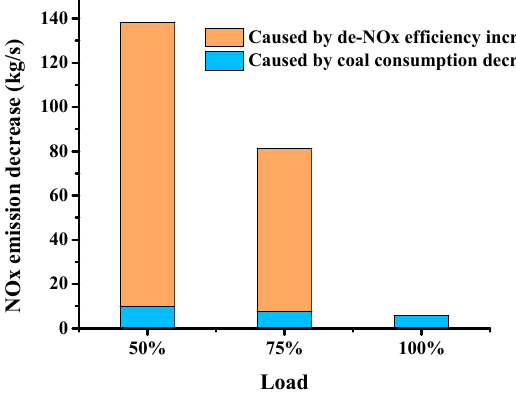
Figure 9. Contribution to NO x emission decrease in the proposed SAPG.